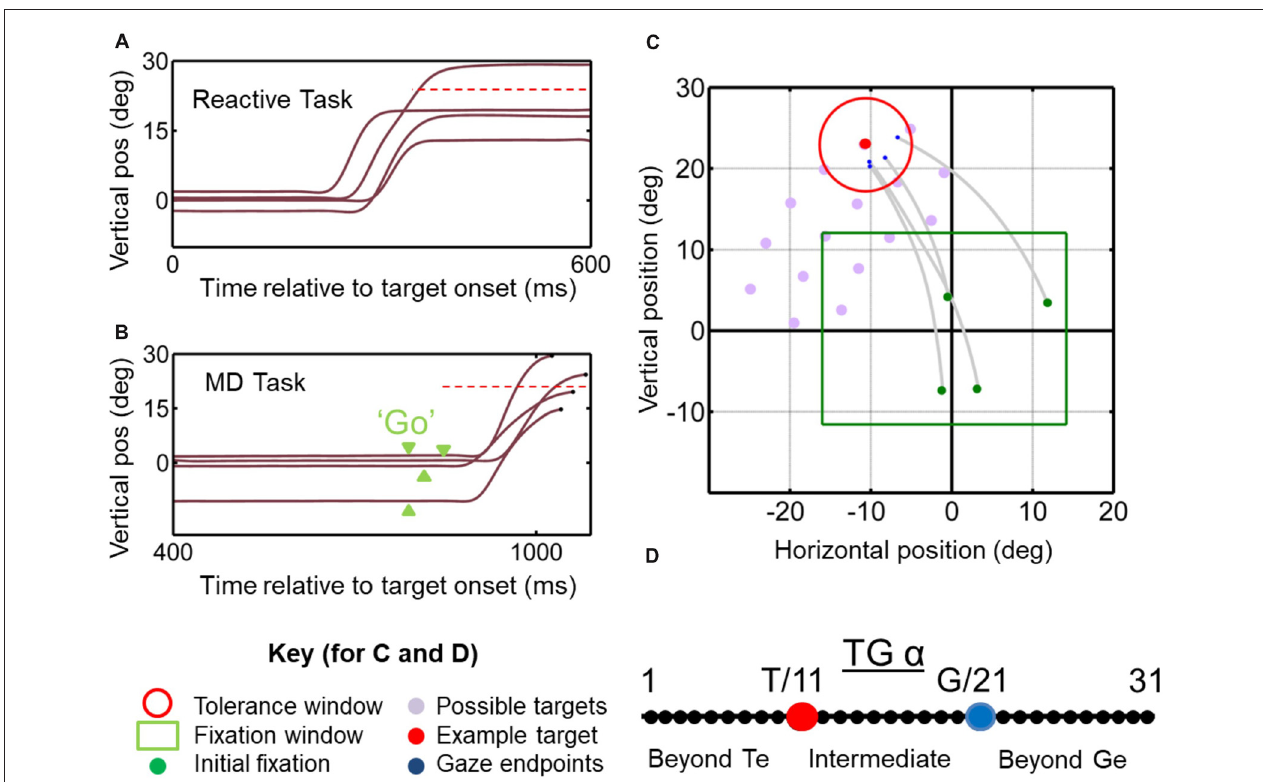
FIGURE 1 | Temporal (A,B) and spatial (C,D) aspects of the behavioral tasks. (A) Vertical gaze position toward an upward target (dashed red horizontal line) plotted as a function of time for example trials in the reactive task . Results from this task are reported in Sadeh et al. (2018). (B) Similar gaze traces for the same target, but obtained from the memory delay task . Note that the memory delay is variable, so the “go” signal (extinction of the fixation point) occurred at different time points (green arrow heads). Results from this task were reported in detail previously (Sadeh et al., 2015). (C) Two-dimensional gaze trajectories (gray lines) from the reactive task for an example target in monkey M2. Also shown are the range of initial fixation positions (green square), the tolerance window (red circle) and the other possible targets used in this experimental session (gray circles) to map a neuron’s receptive field. The identical spatial layouts were used for both tasks to test each neuron. (D) Target-Gaze (TG) continuum constructed between and beyond target position (red dot) and gaze end point (blue dot) for each trial, and used to determine best fits for neural receptive